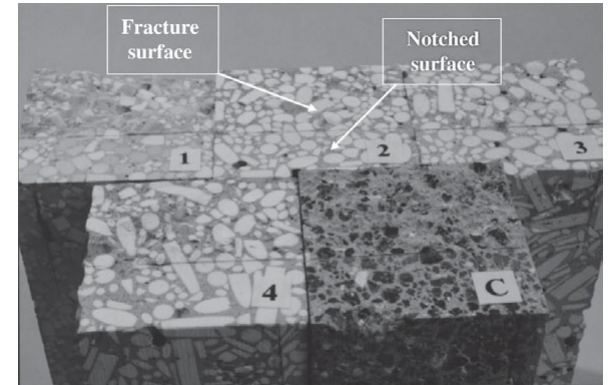
Figure 8. Fracture surface of fired (1000 °C/4 h) specimens AR1, AR2, AR3, AR4 and C.